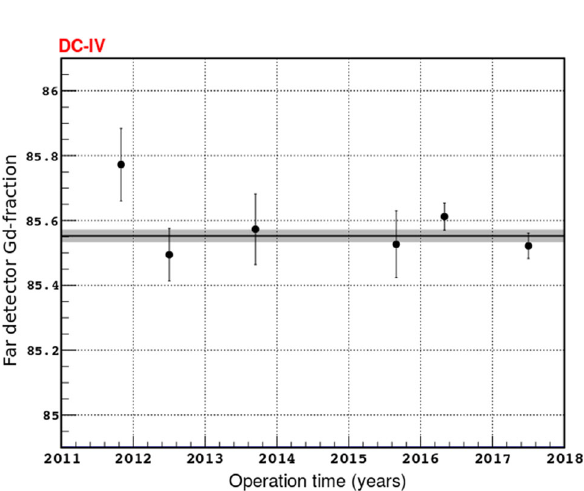
Fig. 27 Gd-fraction stability in the far detector over 7 years of data